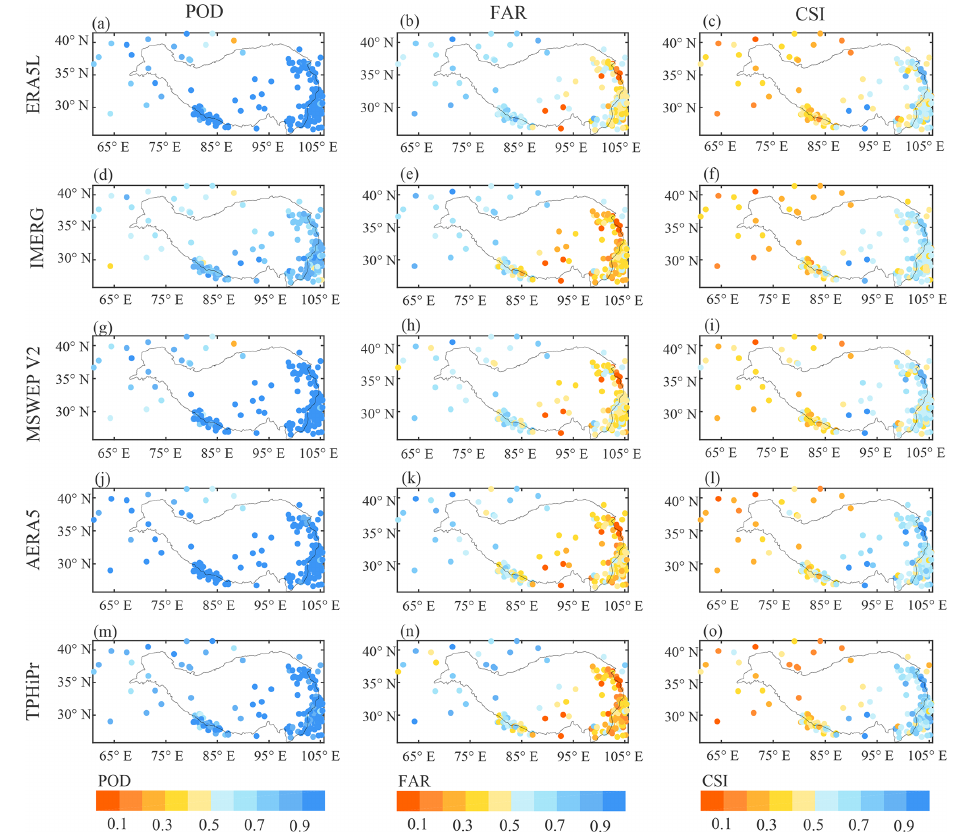
Figure 12. Similar to Fig. 10 but for POD (first column), FAR (second column) and CSI (third column).